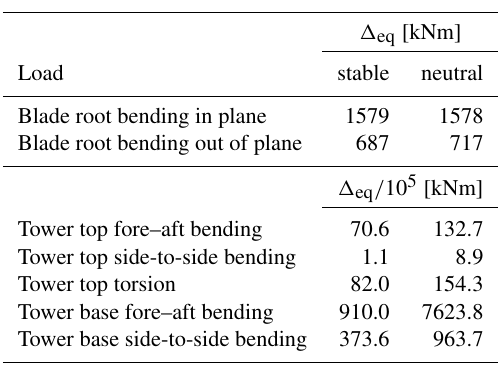
Table 7. Comparison of the equivalent load range (cid:49) eq of the sim- ulation results (10min interval), according to Eq. (3) with m = 10 for blade loads and m = 4 for tower